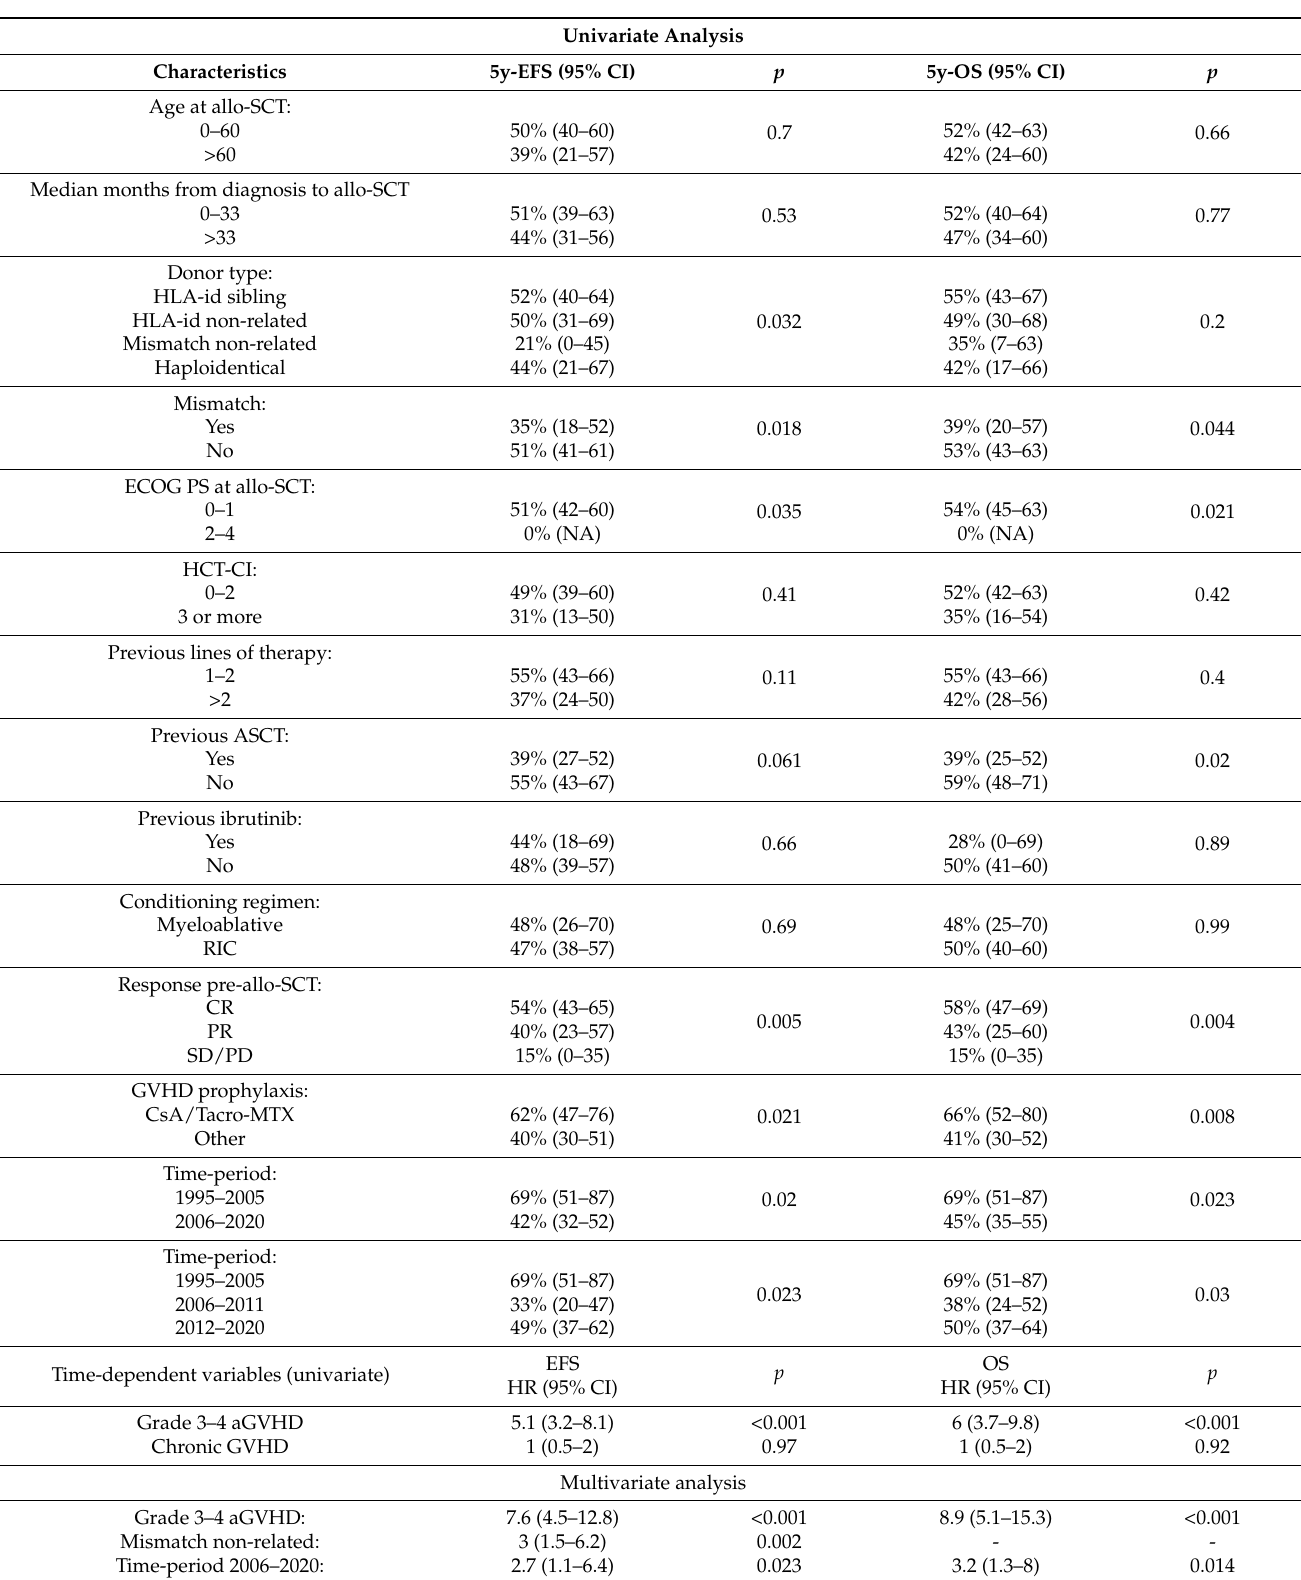
Table 3. Univariate and multivariate survival analysis. Univariate